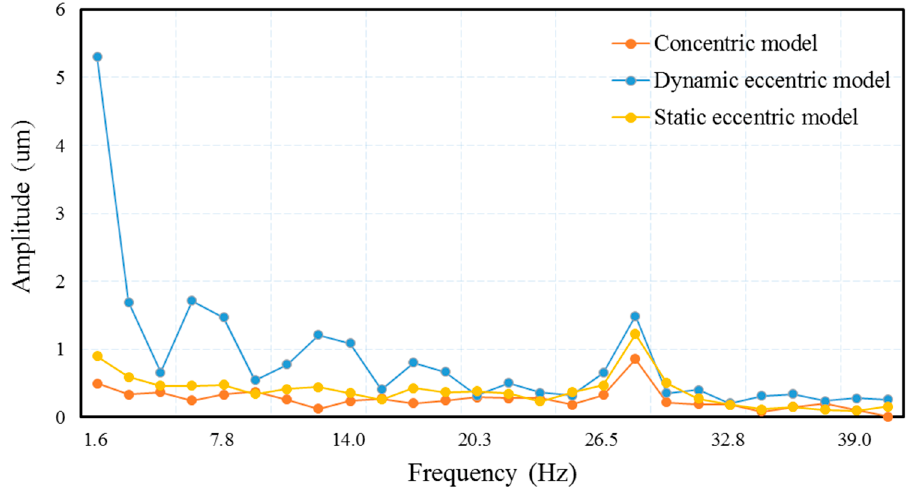
Figure 17. The harmonic response of the studied generator.